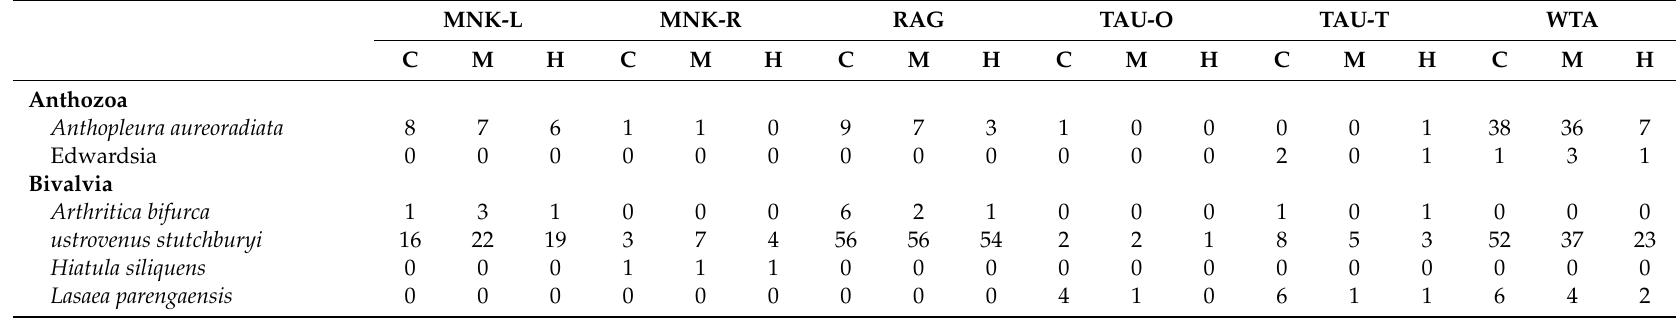
Table A3. Average abundance (n core − 1 ) of taxa as a function of nutrient enrichment treatment in November 2017 (T1; n = 6). Treatments have been abbreviated to C = control, M = medium, H =